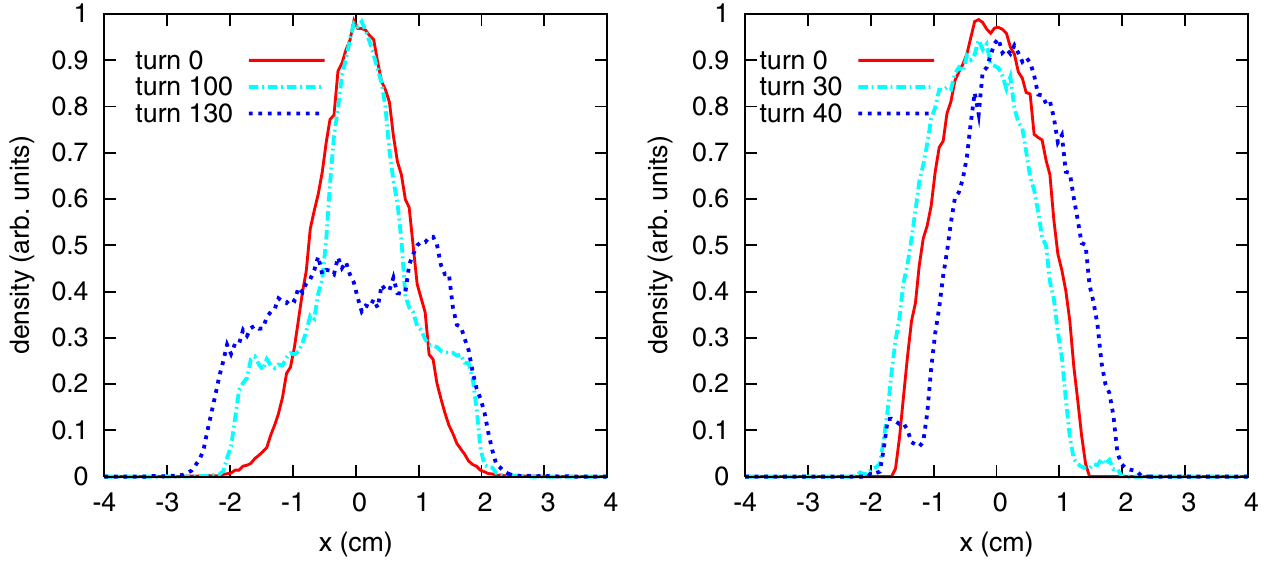
FIG. 7. (Color) Evolution of the beam profile with time for simulation runs made with self-consistent space charge. Left: Gaussian distribution, V (cid:3) 0 : 01 , U (cid:3) (cid:5) 0 : 82 , see Fig. 6 (left). Right: waterbag distribution, V (cid:3) 0 : 012 , U (cid:3) (cid:5) 0 : 7 , see Fig. 4